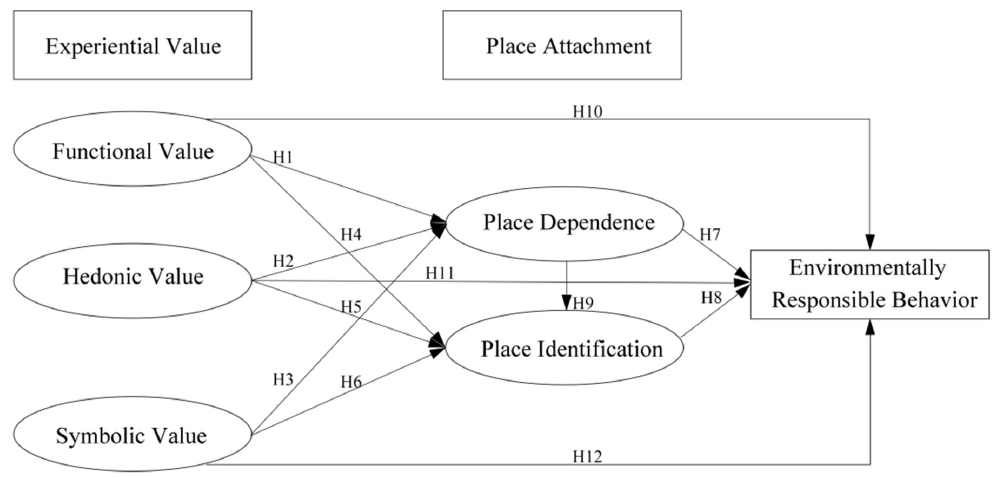
Figure 1. Hypothetical model.